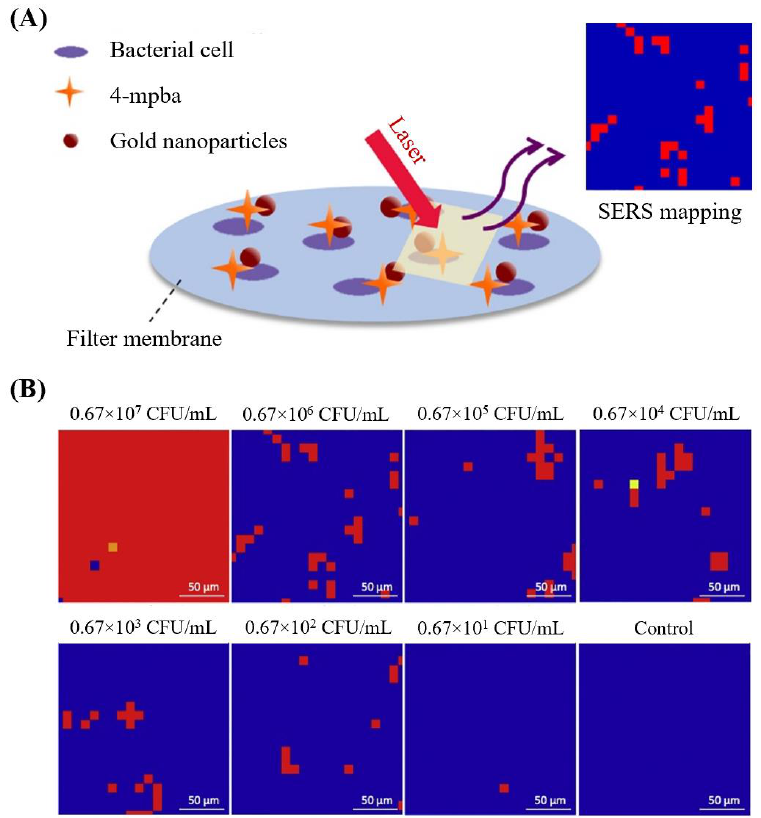
Figure 5. Quantitative SERS detection of pathogens using 4-mpba as capture and indicator combined with filtration. ( A ) Schematic illustration of the bacterial detection by SERS mapping; ( B ) mapping images of E. coli cells at different concentrations [45].